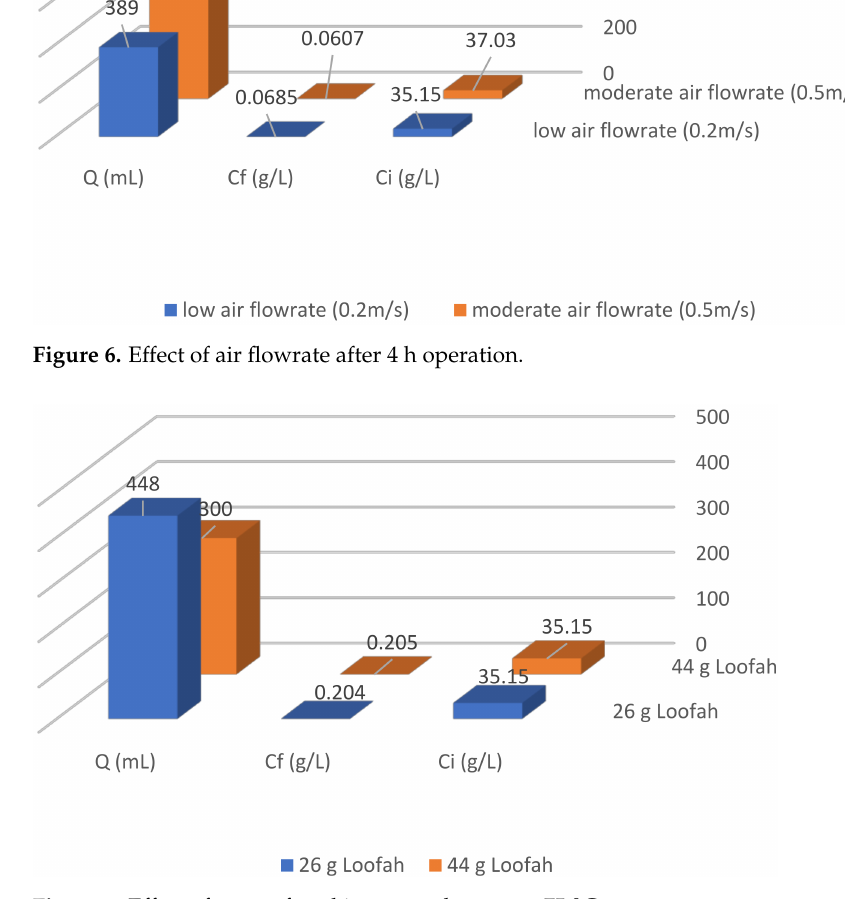
Figure 7. Effect of mass of packing on each stage at 75 ◦